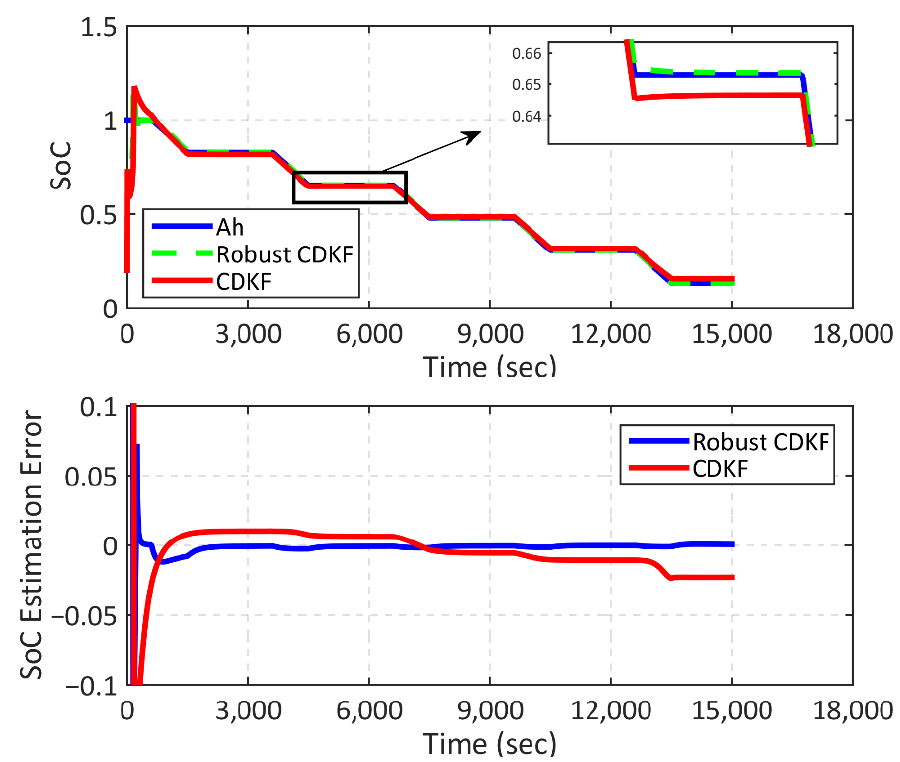
Figure 10. SoC estimation (the time period is 1000 s).